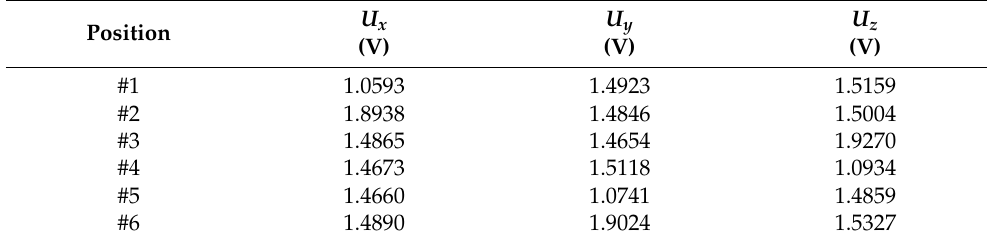
Table 1. Averaged values of the output voltages just after start-up of the sensor.